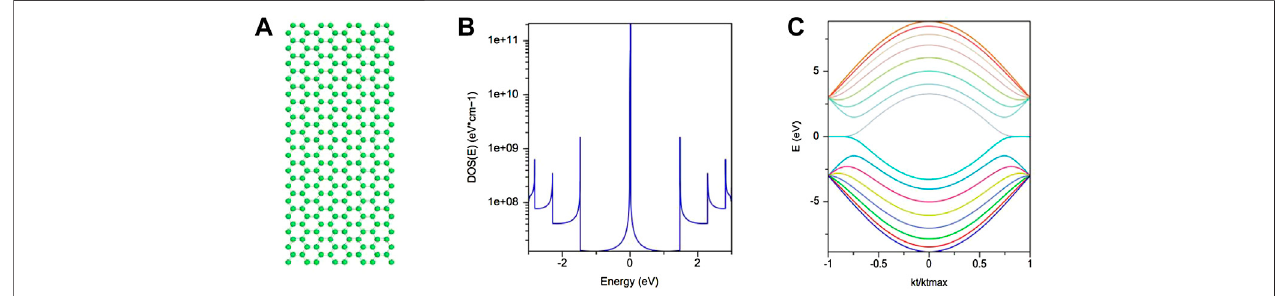
FIGURE13| Whenedgeeffectsarenotconsidered (A) GNRtype-Bwithtight-bindingenergy(3 eV),c-cspacing(1.42A ° ),chirality(8,8), (B) densityofstateplotted with energy, and (C) band structure. We have plotted these results from the nanohub software of Purdue University [4].